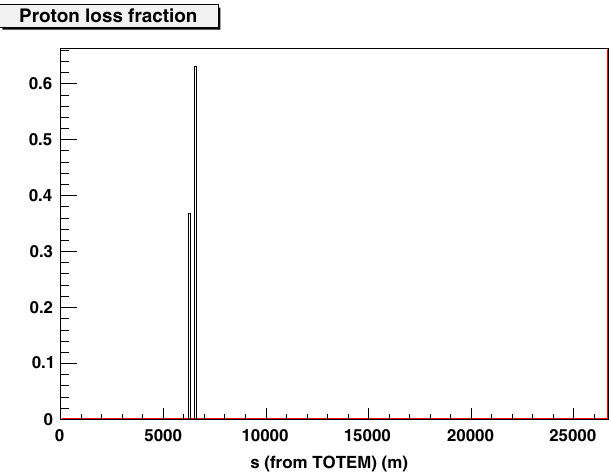
FIG. 11. (Color) The proton loss map around the ring for a circuit error in RD1.LR1. The calculation was made for a 450 GeV stored beam with collision optics. The major loss spike corresponds to loss on a primary collimator.